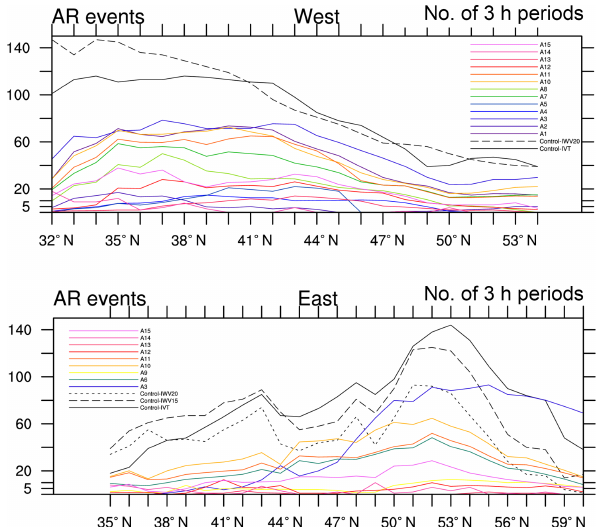
Figure 3. Human control vs. method counts (3h instances) at the coastline for landfalling ARs by latitude for the month of February using MERRA-2 3-hourly data. West refers to North Pacific ARs making landfall along western North America, and east refers to North Atlantic ARs impacting European latitudes. Color lines rep- resent detection algorithms and black lines represent the “human” control. The black solid line represents a static IVT 250kgm − 1 s − 1 threshold, and the black dashed (and dotted) lines represent static 2 and 1.5cm IWV thresholds, respectively. Algorithm identifiers (A1, A2, etc.) are specified in Table